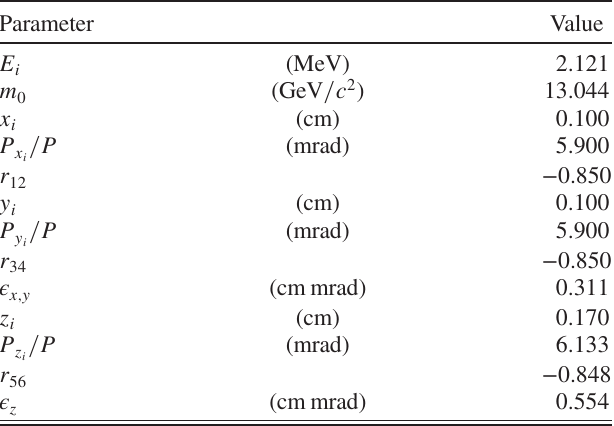
TABLE II. Input TRANSOPTR reference particle parameters and σ matrix used for the comparative simulation shown in Figs. 5 and 6, a 14 N 3 þ beam. Emittances are